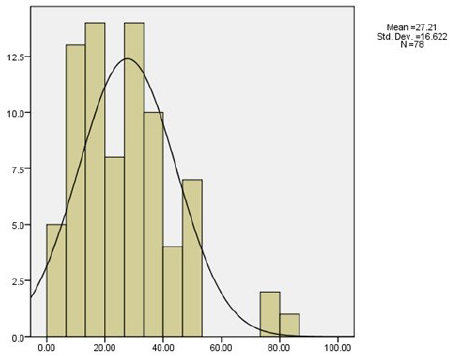
Figure 1. The diameter of the jugular vein before resuscitation (horizontal) by frequency (vertical).